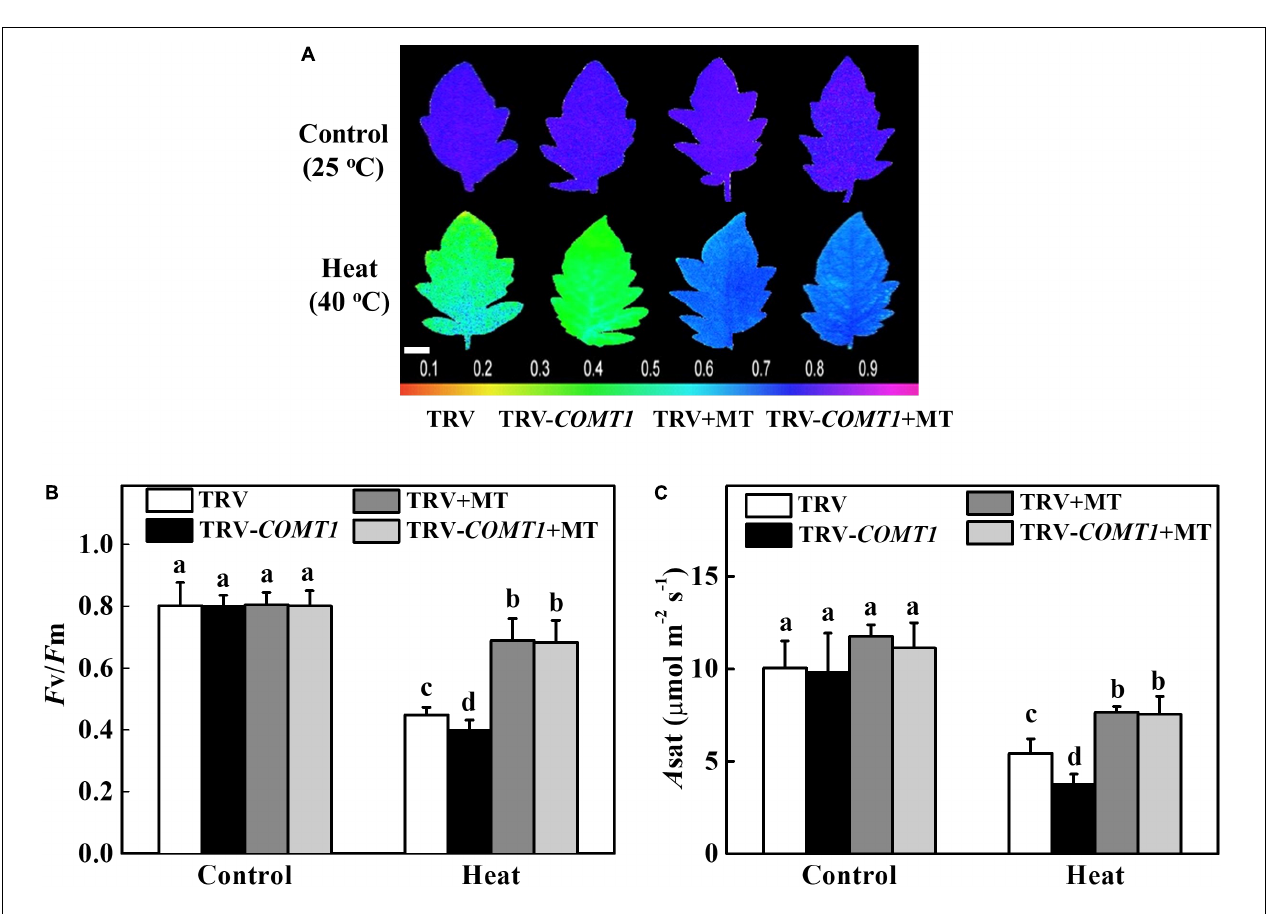
FIGURE 5 | Effects of COMT1 silencing, exogenous melatonin and heat stress either alone or combined on the maximum photochemical efficiency of photosystem II ( F v / F m ) and CO 2 assimilation rate. (A) F v / F m shown in pseudo color images, the false color code depicted at the bottom of the image ranges from 0 (black) to 1 (purple); (B) F v / F m values; and (C) the light-saturated rate of CO 2 assimilation ( A sat ). Tomato seedlings at five-leaf stage were exposed to 40 ◦ C temperature for 9 h before analysis. Plants were pretreated with 10 µ mol L - 1 melatonin on leaves at 8 h prior to imposition of the heat stress. F v / F m and A sat both were measured on the third fully expanded leaves; however, plants were dark adapted for 30 min before recording the F v / F m by using an imaging pulse amplitude modulated (PAM) fluorimeter (IMAG-MAXI; Heinz Walz, Effeltrich, Germany). The results are expressed as the mean values ± SE, n = 6. Different letters indicate significant differences ( P < 0.05) according to the Tukey’s